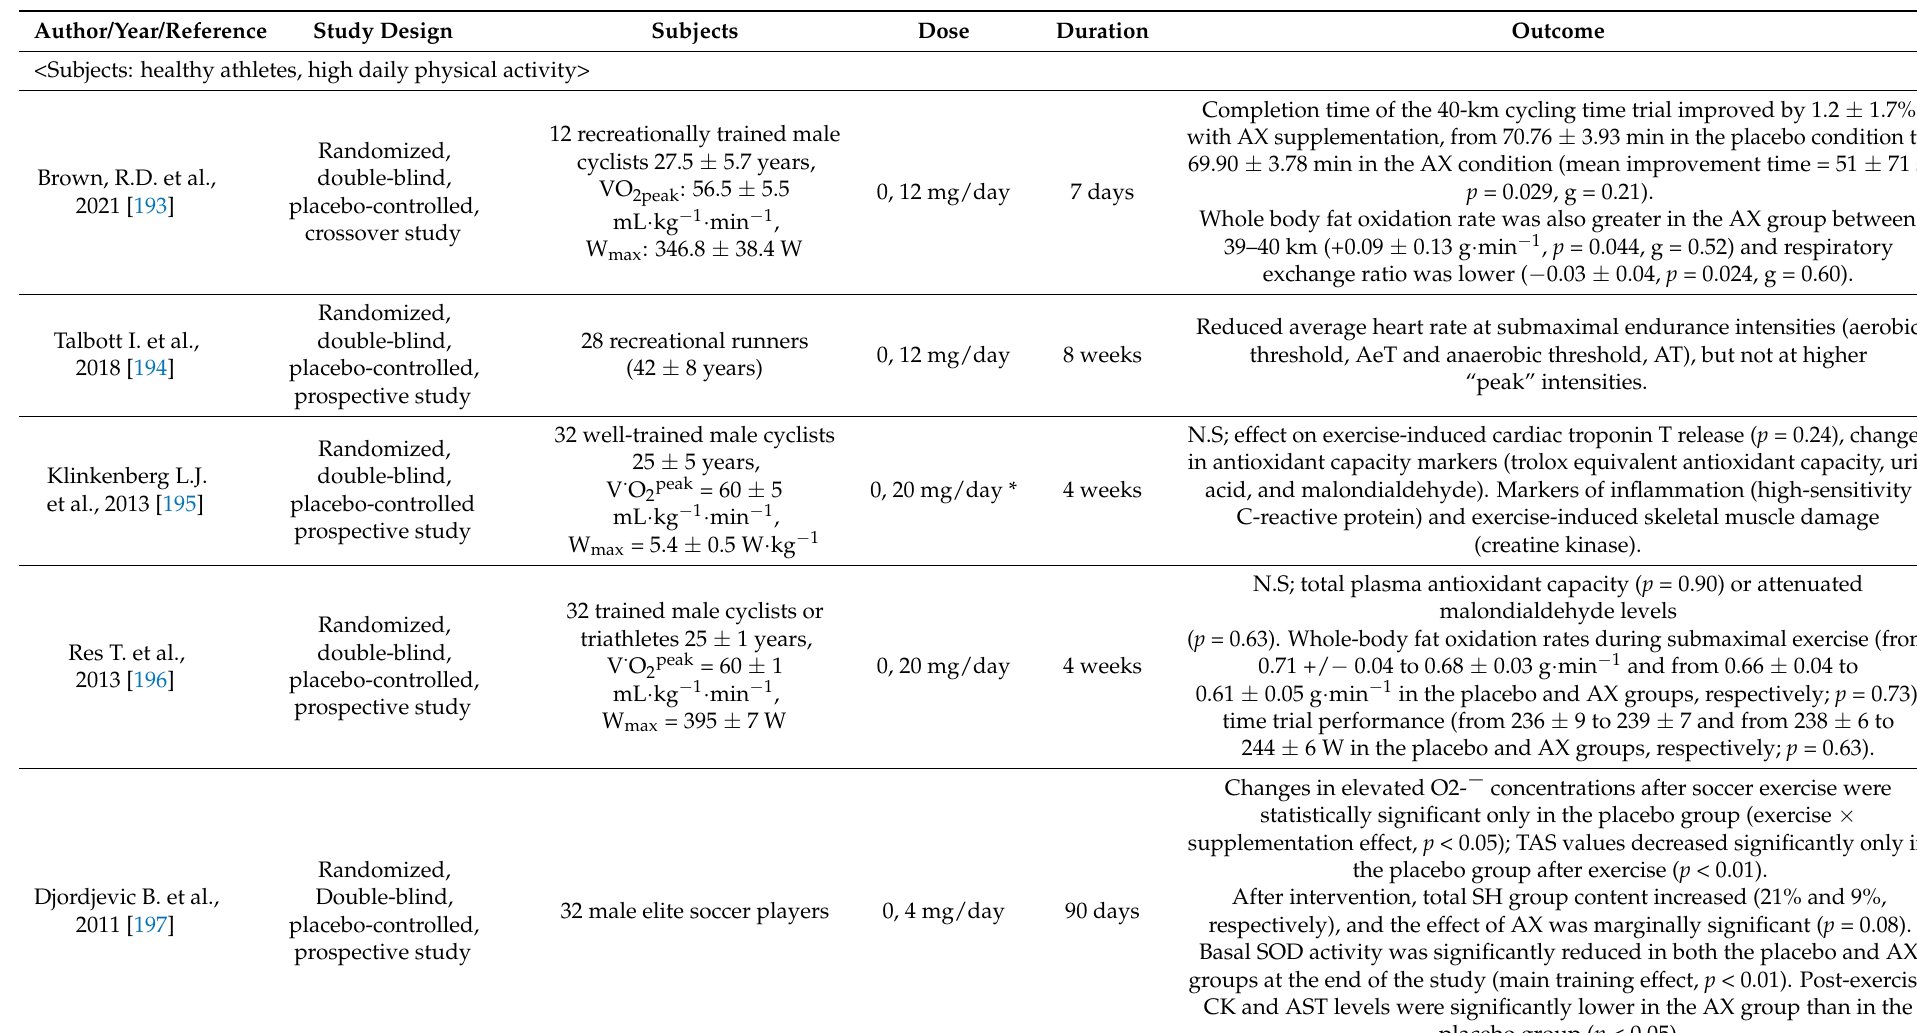
Table 2. Human clinical studies of AX on physical performance, endurance and